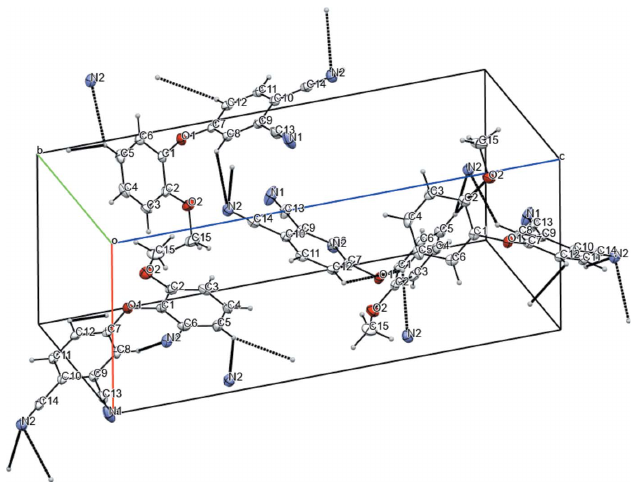
Figure 2 The molecular structure of m -4-(2-methoxy phenoxy)phthalonitrile, showing the atom labeling. Displacement ellipsoids are drawn at the 50% probability level.